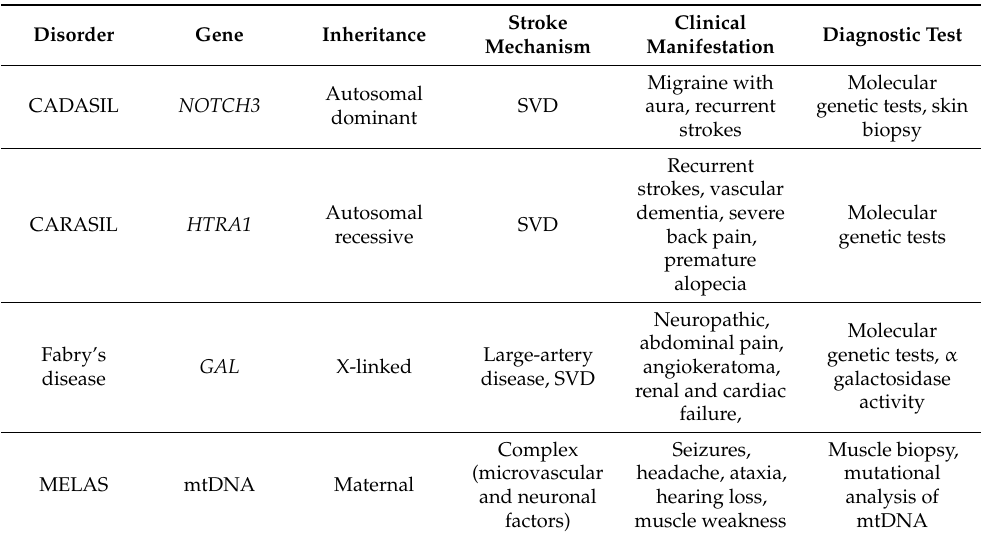
Table 2. Monogenic disorders that include stroke in their phenotypic manifestation (modified from Falcone et